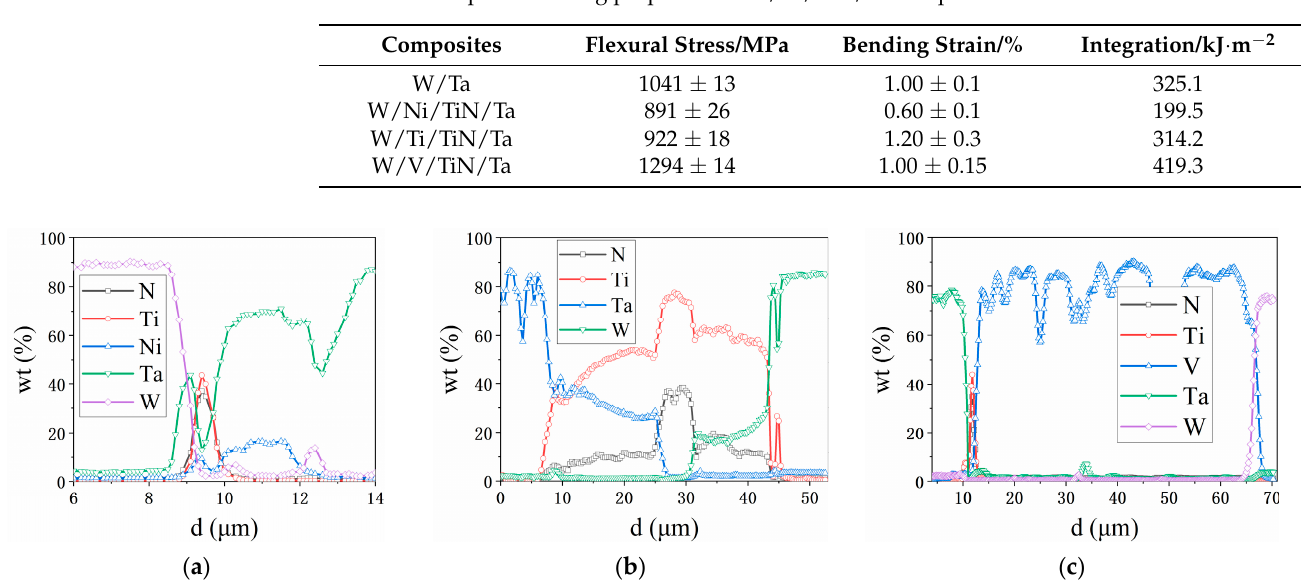
Figure 6. Three-point bending stress-deformation curves of different micron transition layer tough- ened composites joined at 1200 ◦ C. Table 6. Three-point bending properties of W/M/TiN/Ta composites as SPSed at 1200 ◦ C.